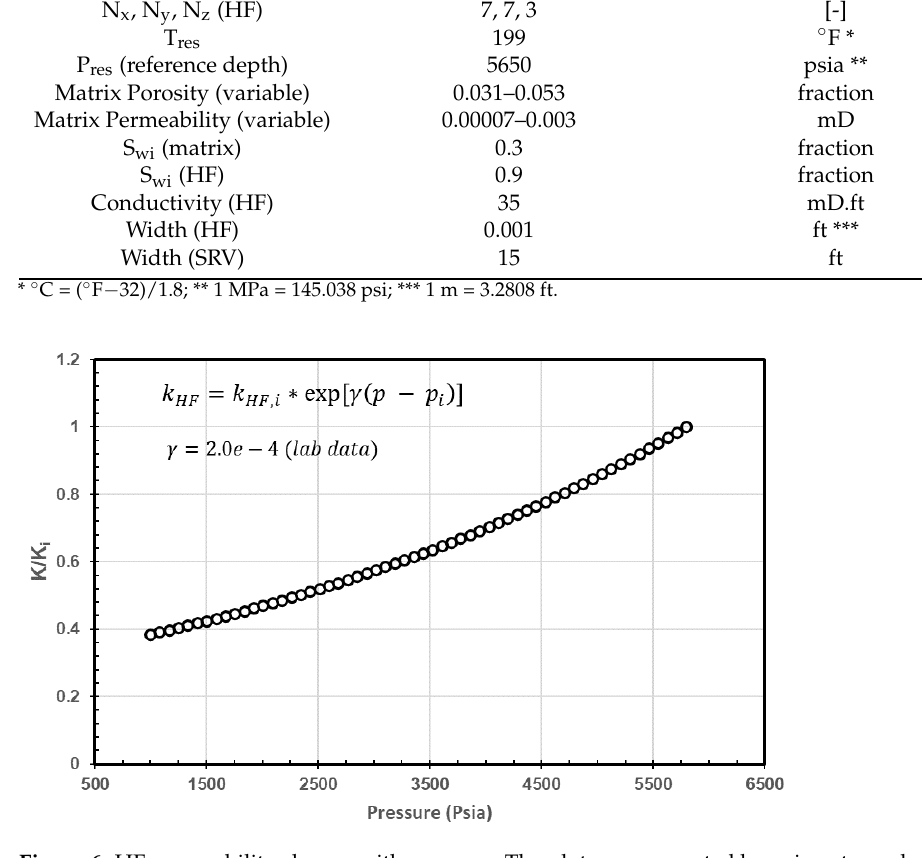
Figure 6. HF permeability change with pressure. The plot was generated by using stress-dependent propped fracture permeability data measured in the laboratory. Table 2. The list of the parameters (and their ranges) used in history matching with the CMG CMOST